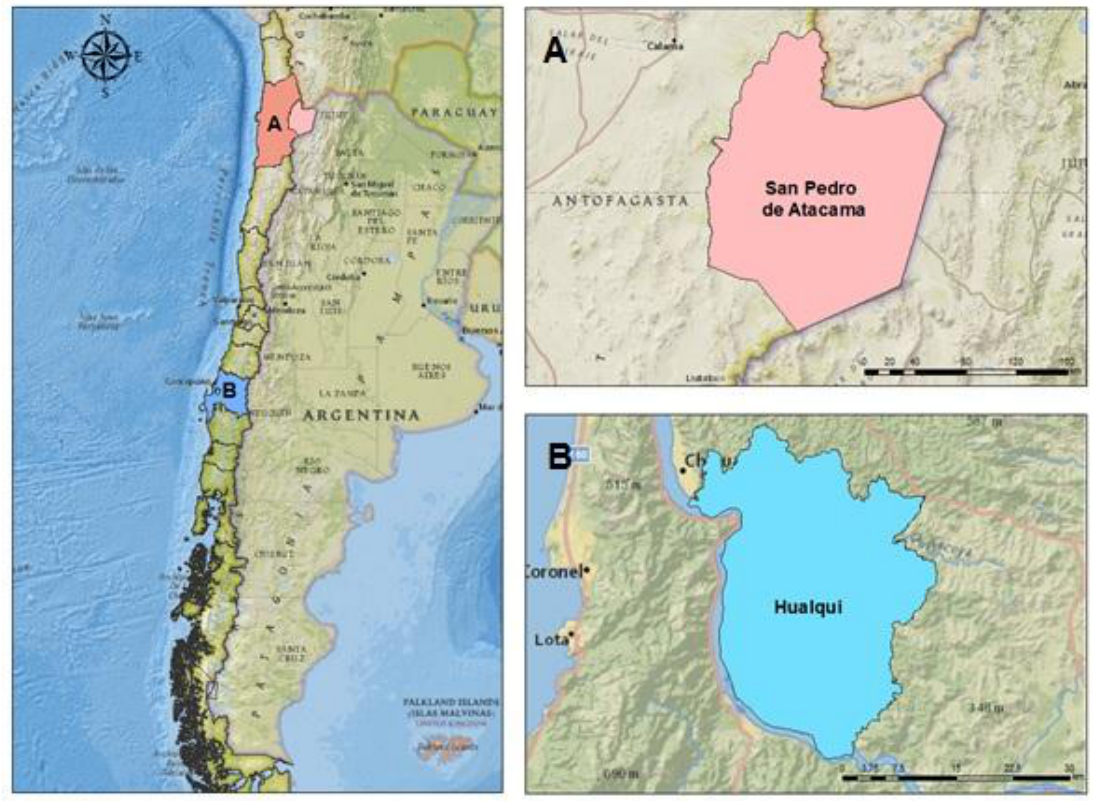
Figure 1. Geographical locations of the survey communities in Chile. ( A ) Desert region, community under study: San Pedro de Atacama. ( B ) Humid region, community under study: Hualqui.